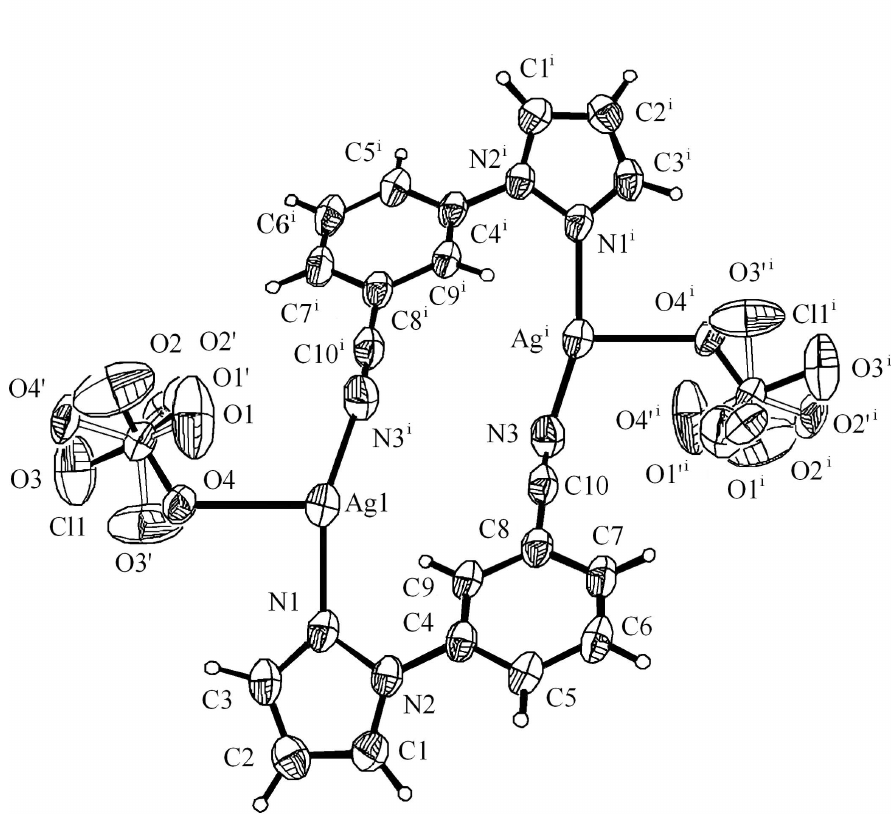
Figure 1 A view of the Ag I coordination environment in the dimeric structure of (I), showing the atom-labelling scheme. Displacement ellipsoids are drawn at the 30% probability level and H atoms are shown as small spheres of arbitrary radii. [Symmetry codes: (i) - x + 1, - y + 1, - z + 2] The minor component of disorder is shown with open